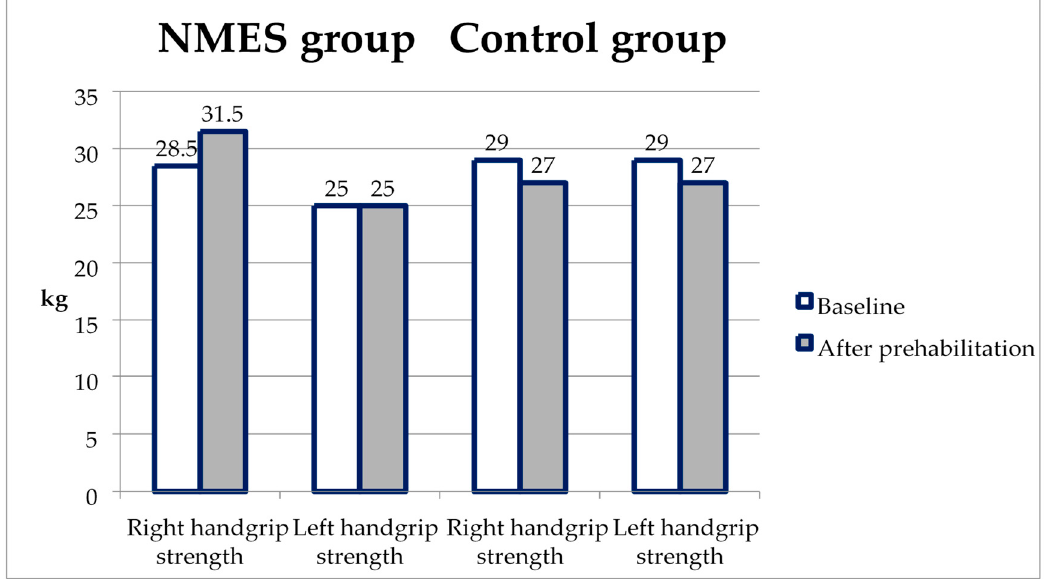
Figure 4. Changes in handgrip strength from baseline to the second test in the NMES group and control.